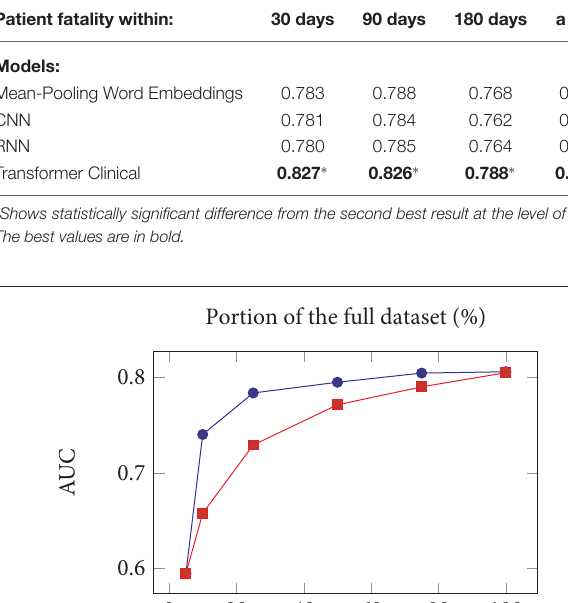
TABLE 11 | Comparison of the deep neural models on the head (first 512 tokens) portions of discharge summaries for patient fatality prediction targets. Patient fatality within: